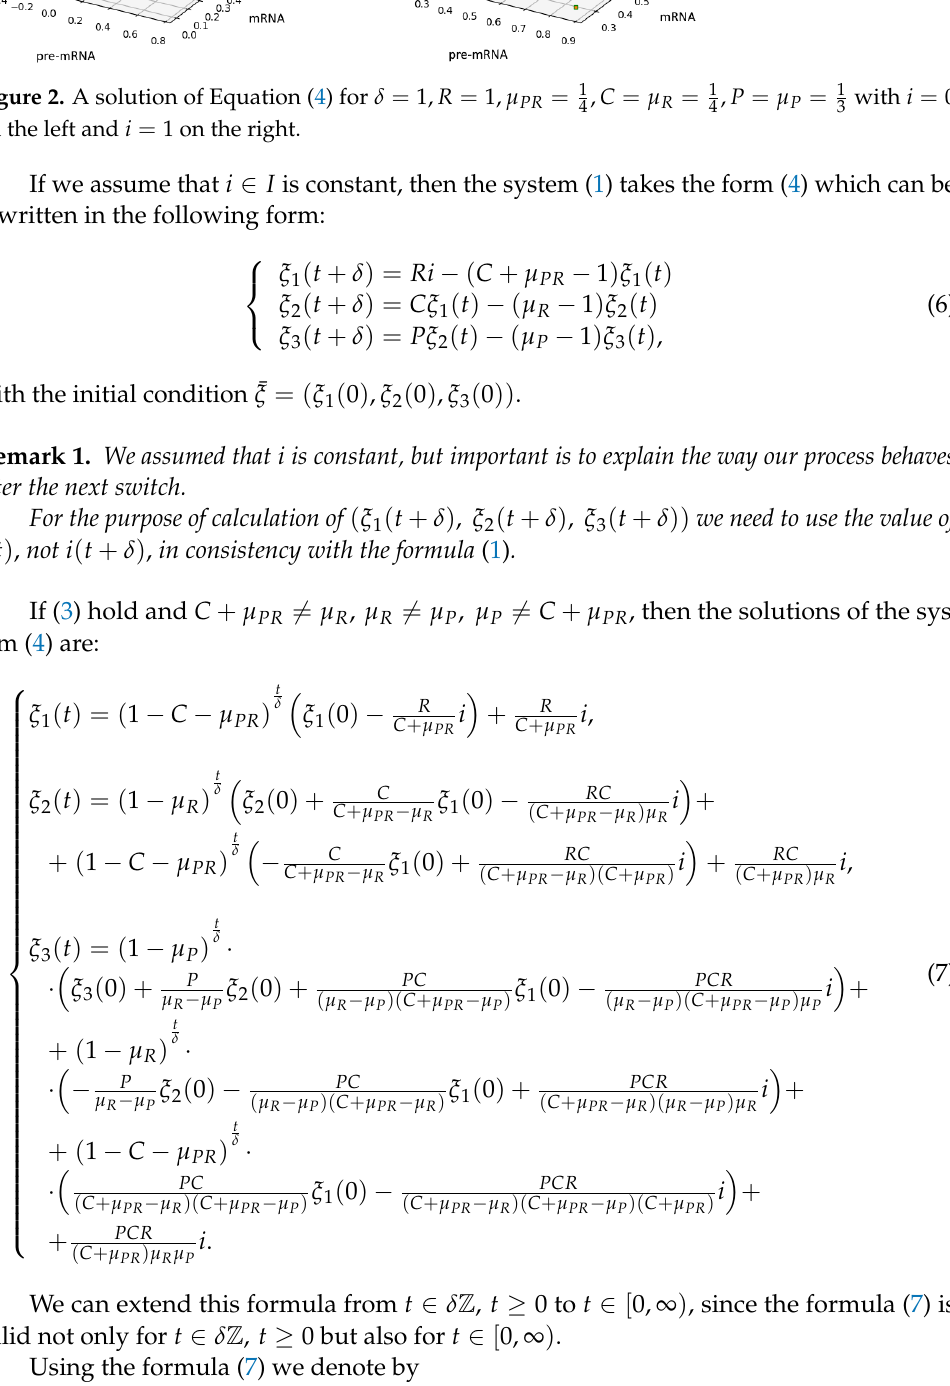
, C = µ R = 1 , P = µ P = 1 with i = 0 3 4 4